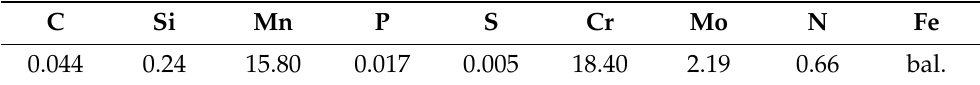
Table 1. The chemical composition of the HNSS